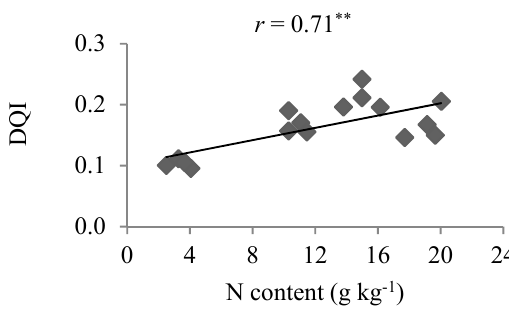
Figure 3. Correlation between leaf N content and Dickson quality index (DQI) in the experimental plot samples of Eucalyptus spp. rooted cuttings, ** Significant at 1% using the t-test.